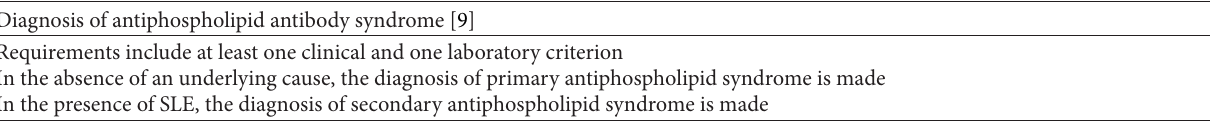
Table 2: Sapporo criteria for diagnosis of antiphospholipid antibody syndrome.